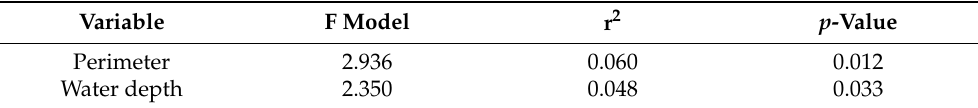
Table 2. Dependence of the community composition on significant environmental variables accord- ing to the PERMANOVA. “F Model” indicates variation within the samples, and “r 2 ” shows the percentage of the explained